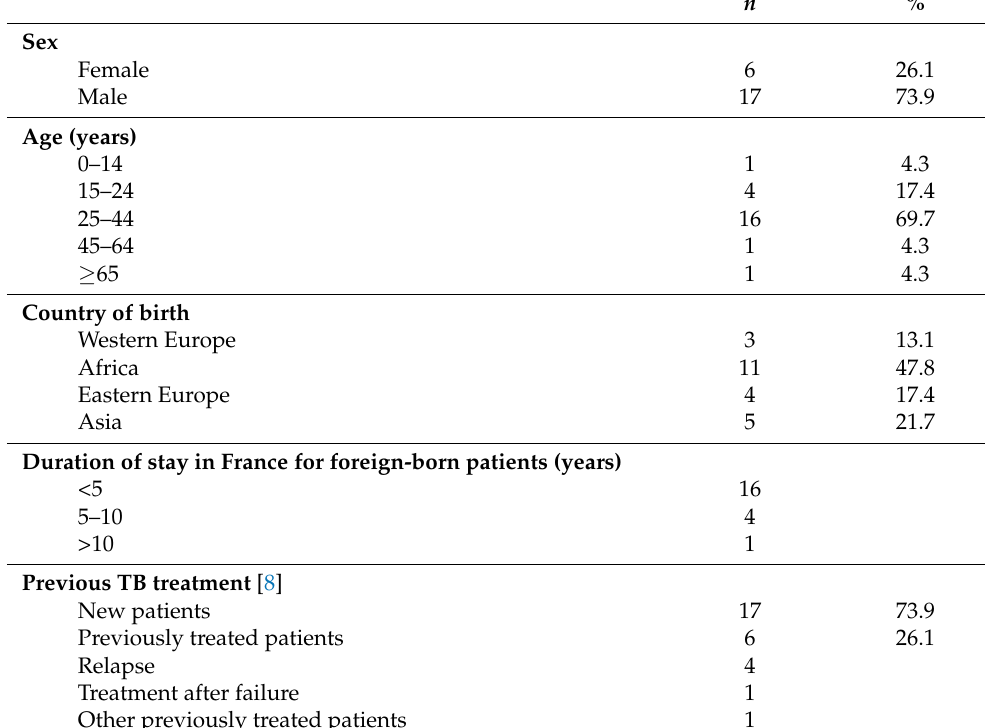
Table 1. Characteristics of 23 patients with multidrug-resistant osteoarticular TB in France from 2007 to 2018.